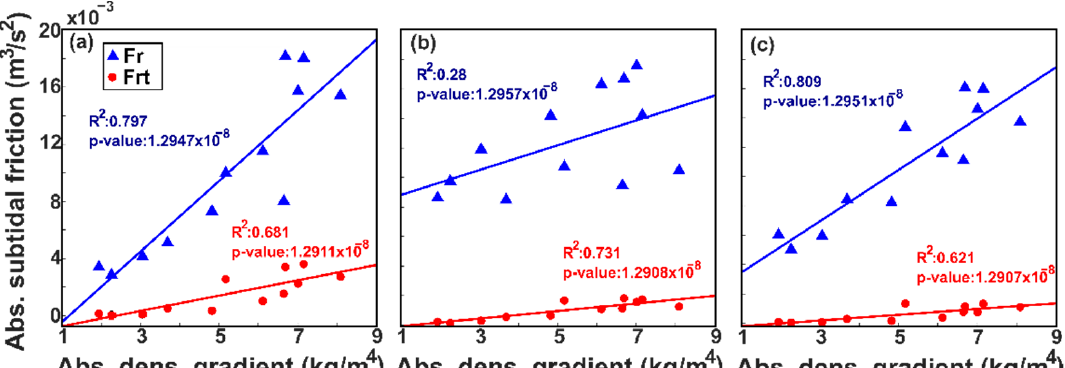
Figure 11. The longitudinal subtidal density gradient vs. Fr (blue triangles) and Frt (red dots) at Stations A ( a ), B ( b ), and C ( c ). The trendlines denote the linear relationship between the density gradient with Fr (blue lines) and Frt (red lines).